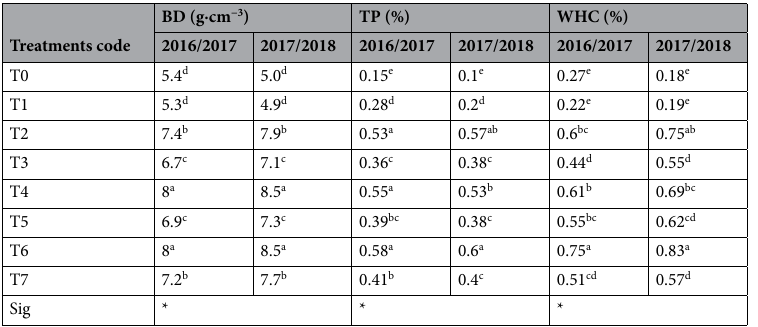
Table 3. Effect of treatments on soil physical properties in 2016/2017 and 2017/2018 cropping seasons. Values followed by similar letters under the same column are not significantly different at p = 0.05. T0 = control (no amendement), T1 = IF: 13-13-23 NPK at 450 t ha −1 + urea at 100 t ha −1 , T2 = TB at 20 t ha −1 , T3 = TB at 10 t ha −1